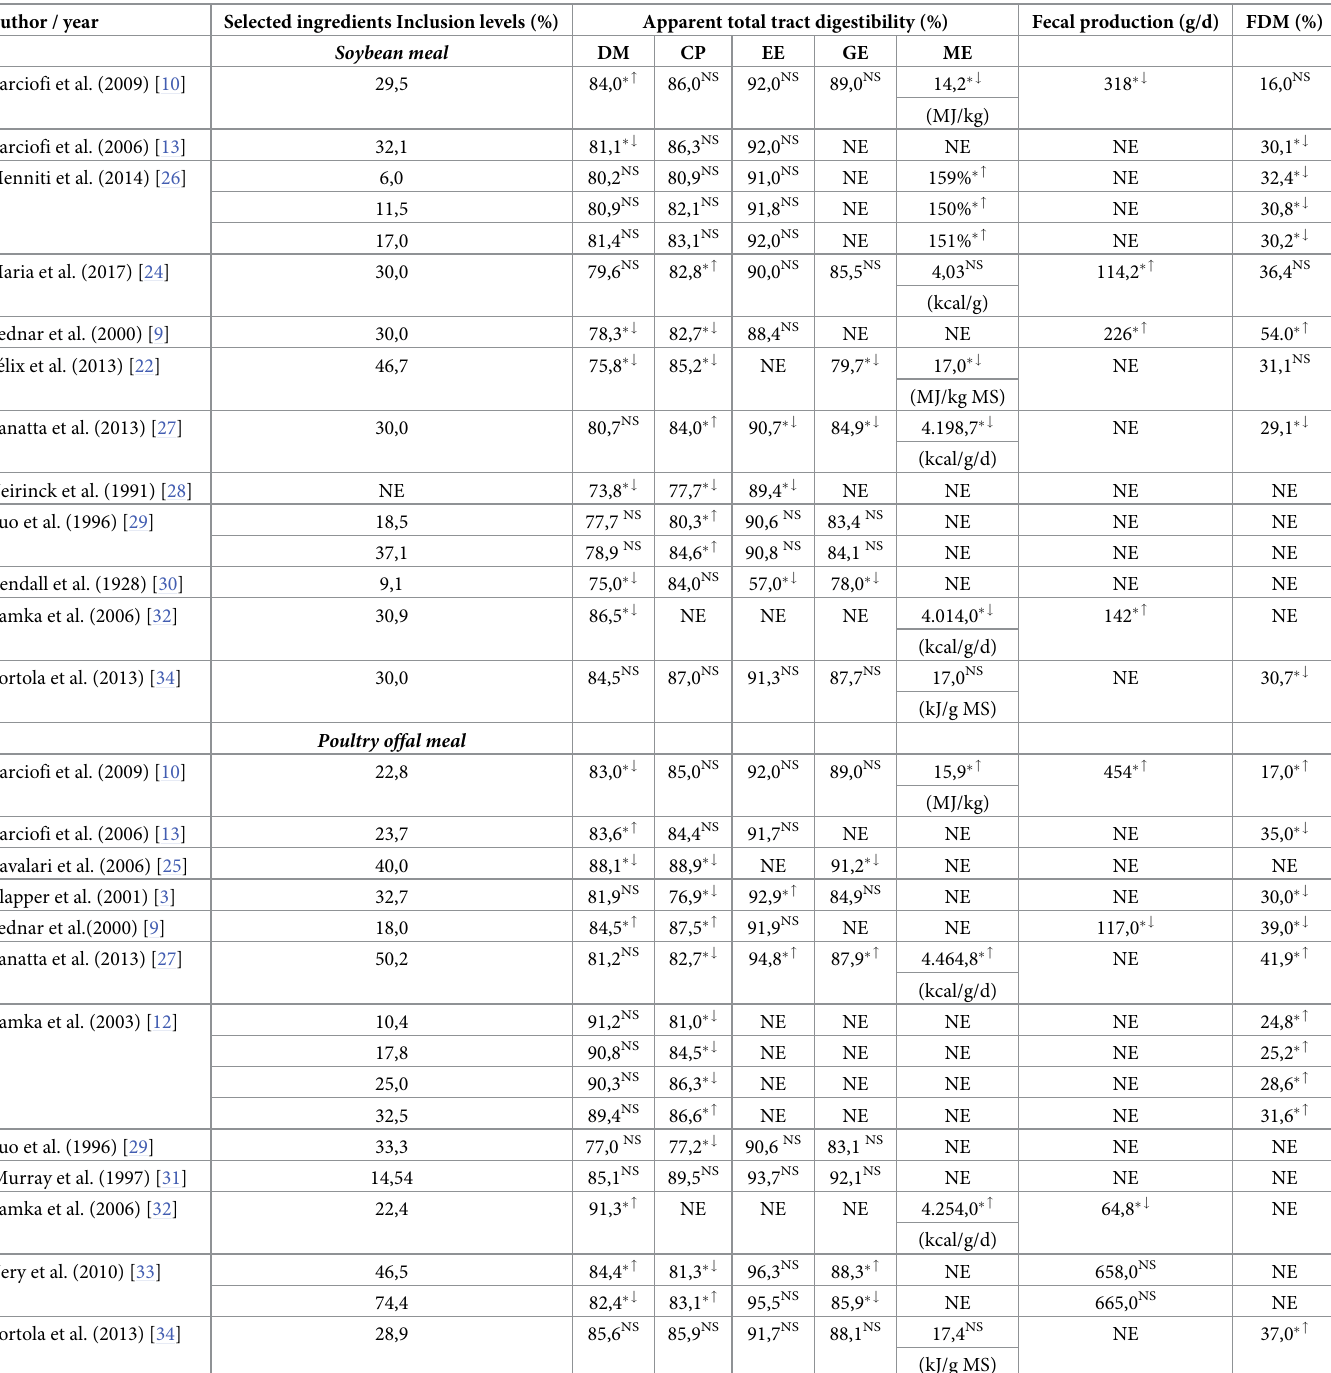
Table 5. Inclusion effects of soybean meal and poultry offal meal under digestibility coefficients, metabolizable energy, fecal production and fecal dry